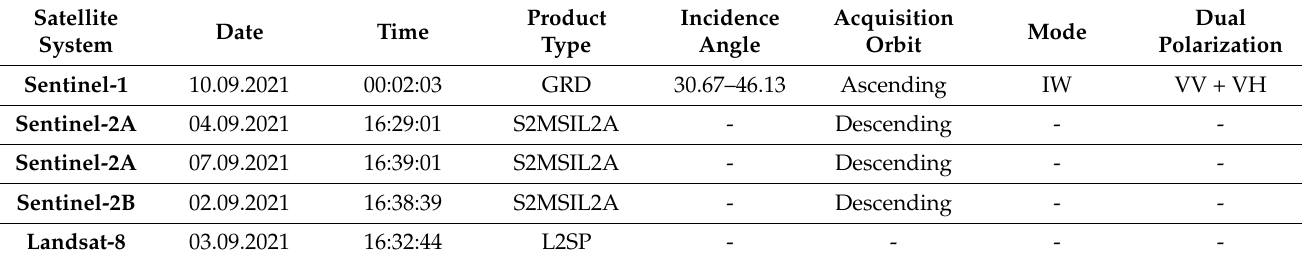
Table 1. List of SRS data used.